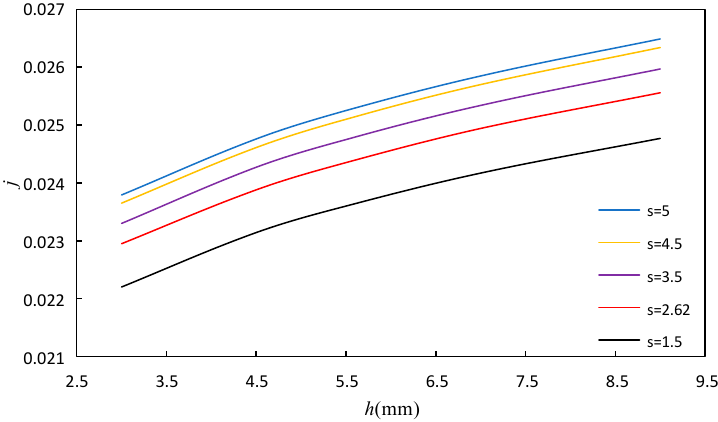
Figure 10. E ff ect of fi n height and fi n spacing on j. Figure 10. Effect of fin height and fin spacing on j